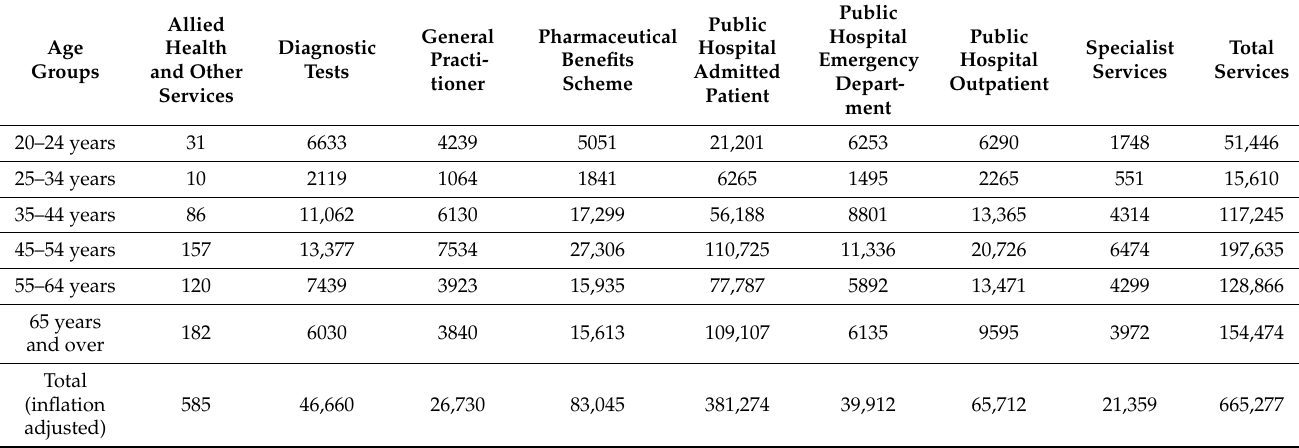
Table A5. Extra costs incurred due to LHL for people diagnosed with Chronic kidney disease in the Blacktown LGA (Domain